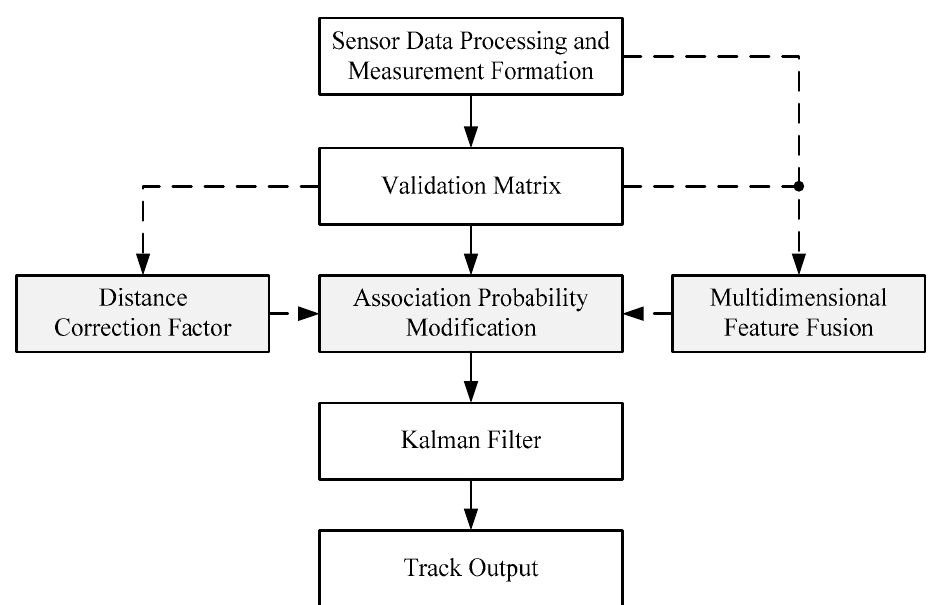
Figure 1. Flow diagram of the proposed insect target tracking algorithm.